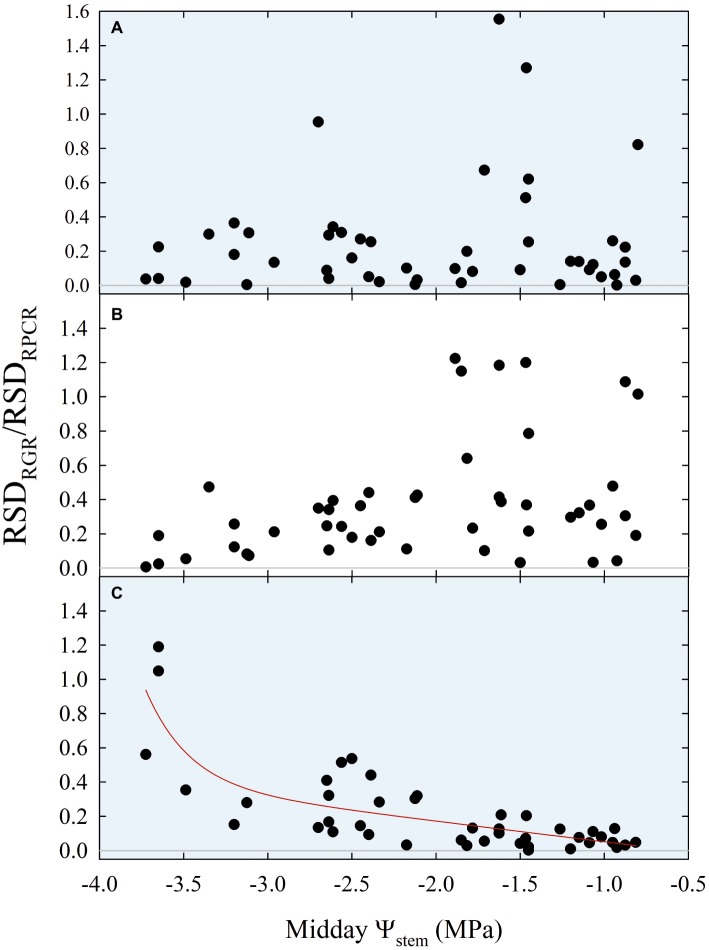
Diel (A), diurnal (B), and nocturnal ratios (C) of relative standard deviations of fruit relative growth rate (RSDRGR) and leaf relative pressure change rate (RSDRPCR) vs. midday Ψstem for all fruit growth stages and irrigation treatments. Expo-linear model in panel (C): RSDRGR/RSDRPCR = −0.07 + 2.88E-07 × exp. (−3.89 × Ψstem) − 0.12 × Ψstem, R2 = 0.650, p < 0.001.